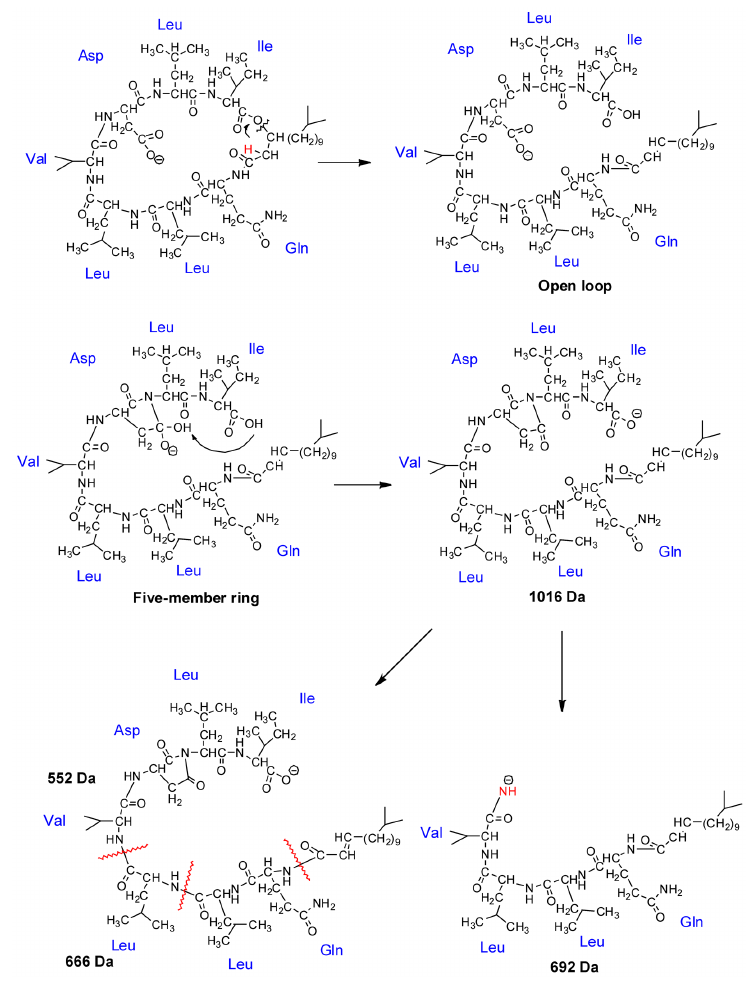
Figure 4. The fragmentation mechanisms of lichenysins G.